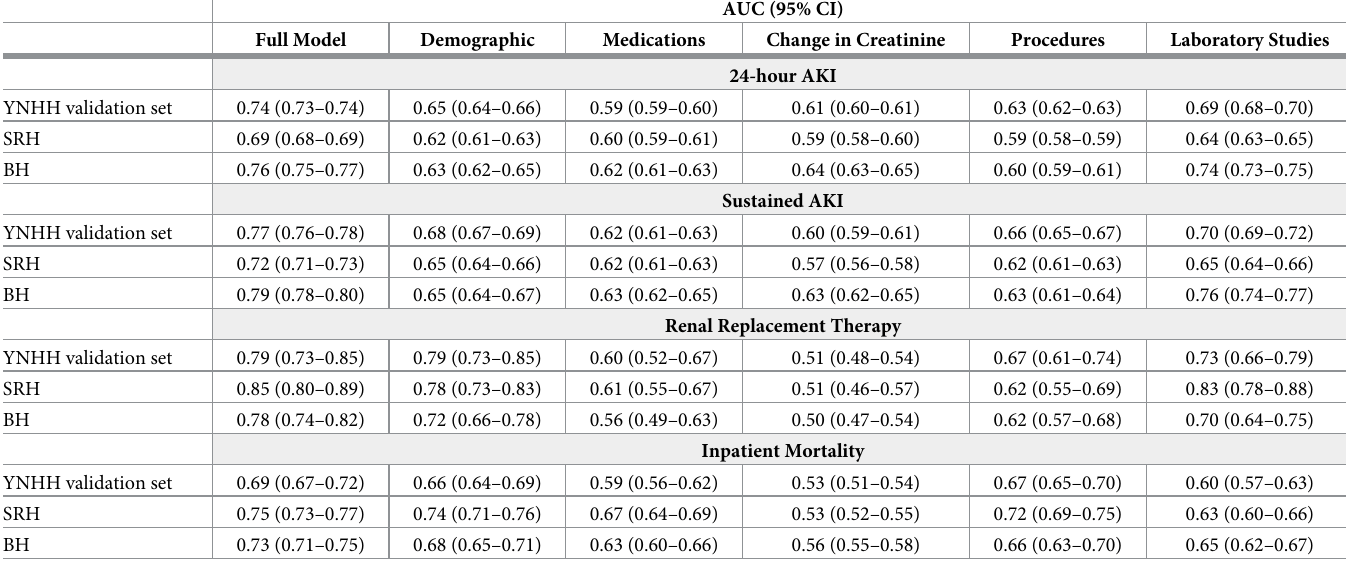
Table 4. Model performance for prediction of 24-hour AKI and related outcomes. Performance of multivariable models for prediction of 24-hour AKI, sustained AKI, renal replacement therapy, and inpatient mortality, with columns signifying models utilizing different subsets of input variables. Model performance is displayed as AUC for each model when applied to data from the YNHH validation set and SRH and BH data